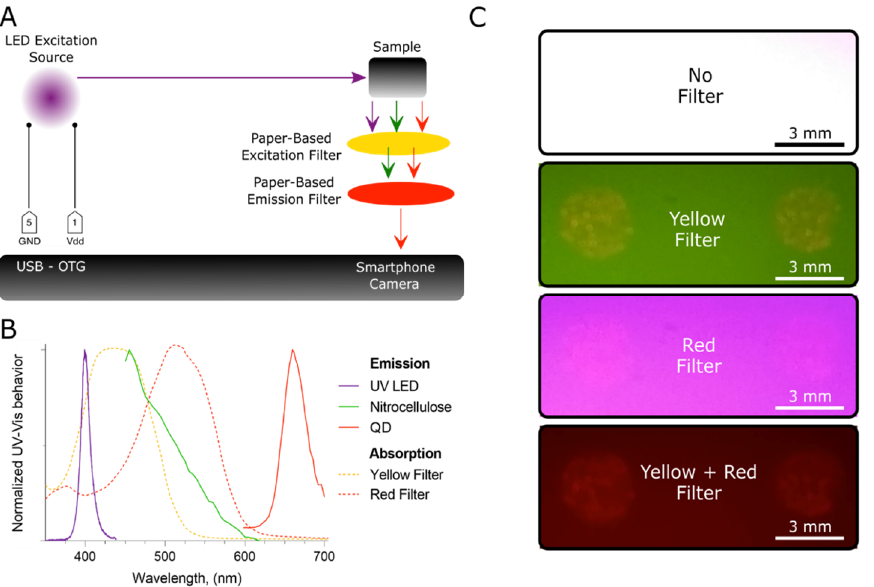
Figure 2. Optical components of the paper-based QD reader and their characterization via ultraviolet–visible (UV–Vis) spectroscopy. A . Schematic representation of the optical path. B . UV-Vis behavior of the optical components. C . Images recorded with different filter configurations. The images were acquired through the smartphone camera.